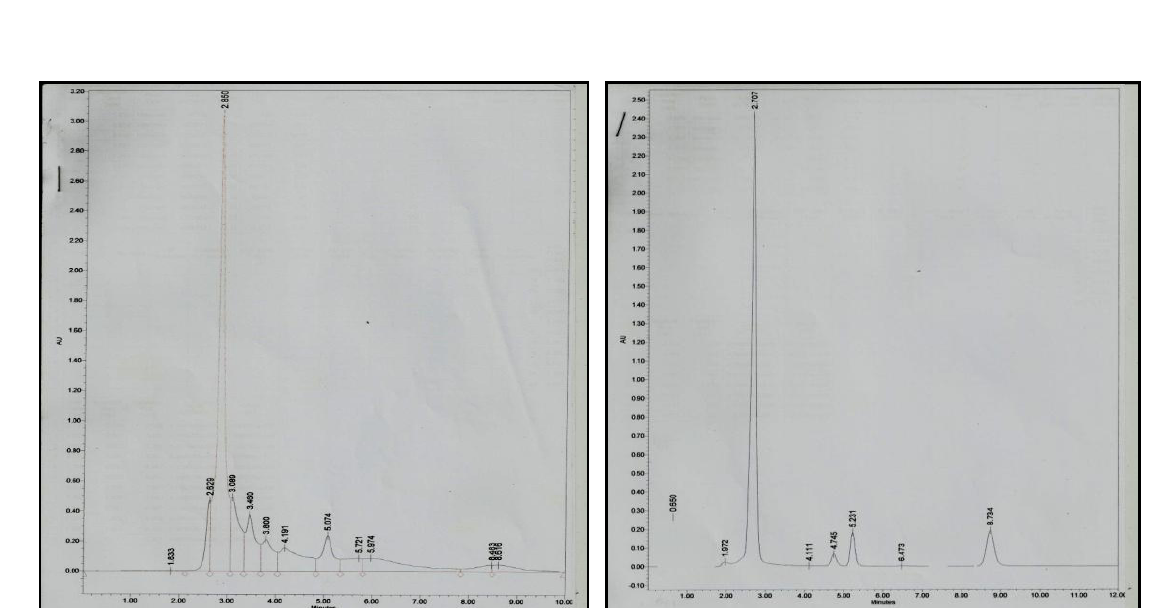
Figure 2: HPLC analysis of std. Arctiin, std. Arctigenin, std.Caffeic acid and methanolic extract of leaf &root sample